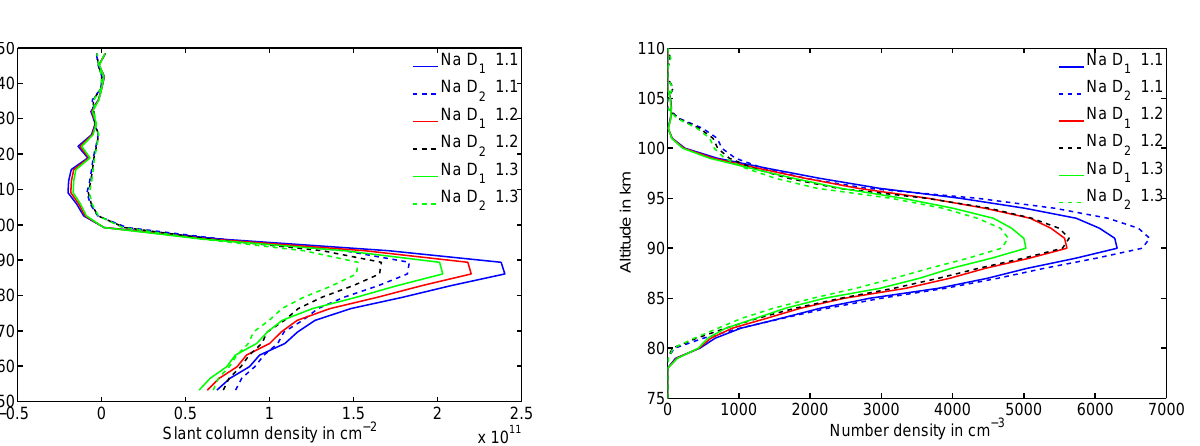
Figure 6. Vertical SCD profile for both Na D lines (6 October 2009, 35 ◦ N) for three different albedo factors (1 . 1–1 . 3). The SCDs of the D 2 line are smaller because of stronger self-absorption.